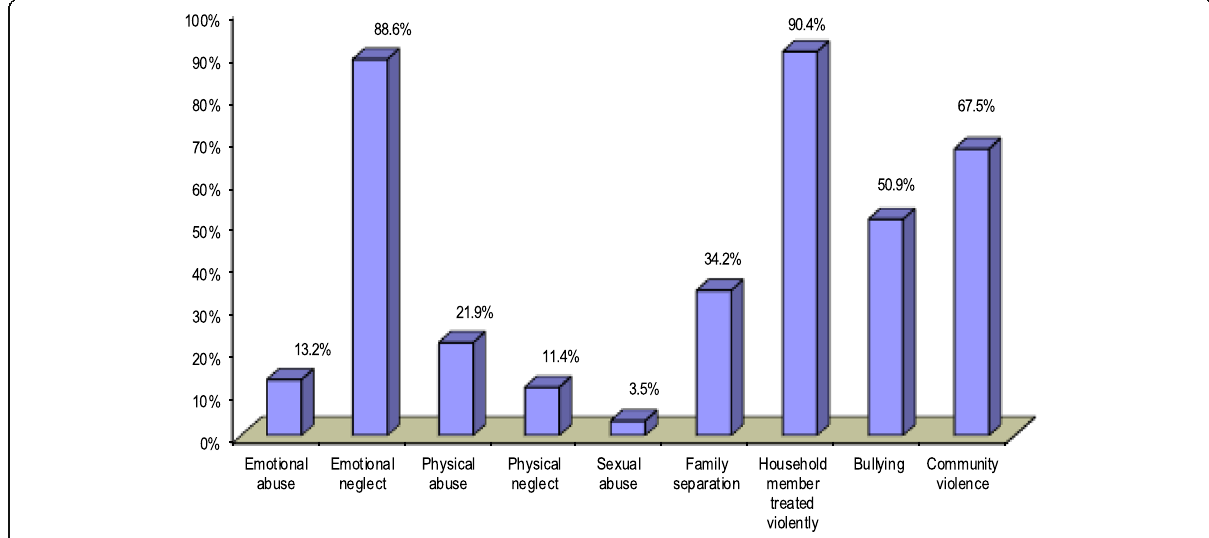
Fig. 1 Percentage distribution of different adverse childhood experiences among the studied sample